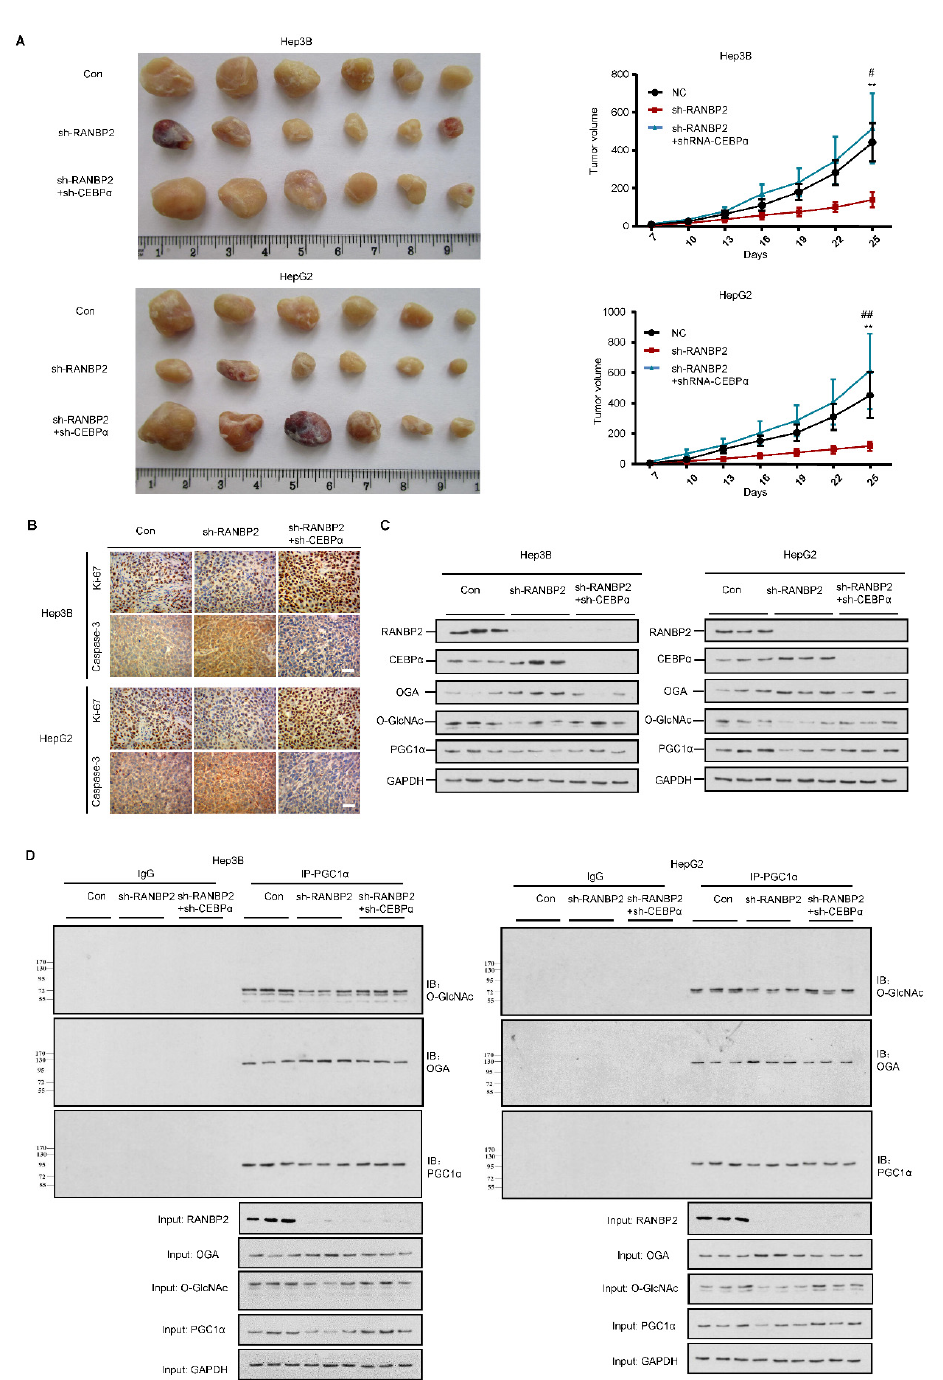
Figure 6. RANBP2 triggers HCC tumorigenicity via CEBP α -associated imbalance of O-glycosylation homeostasis in vivo. ( A ) Silencing of RANBP2 retarded HCC tumor growth, which was effectively counteracted by CEBP α depletion. The sizes of Hep3B and HepG2 tumors formed in the mice with subcutaneous implantation were monitored every three days. Data are presented as the mean ± SD values (n = 6). sh-RANBP2 + sh-CEBP α group: ** vs. NC, ** p < 0.05; # vs. sh-RANBP2, # p < 0.05, ## p < 0.01 ( t -test). ( B ) HCC tumorigenicity was confirmed by immunohistochemical staining of the isolated subcutaneous tumor tissue. sh-RANBP2 significantly decreased the proliferating marker Ki-67, while it increased the apoptosis marker caspase-3. sh-CEBP α was demonstrated to have opposite effects. Scale bars, 20 mm. ( C , D ) Downstream effectors of RANBP2 and CEBP α related to O -GlcNAc modification and tumor promoter PGC1 α were tested by immunoblotting ( C ) and co-immunoprecipitation ( D ) in xenograft